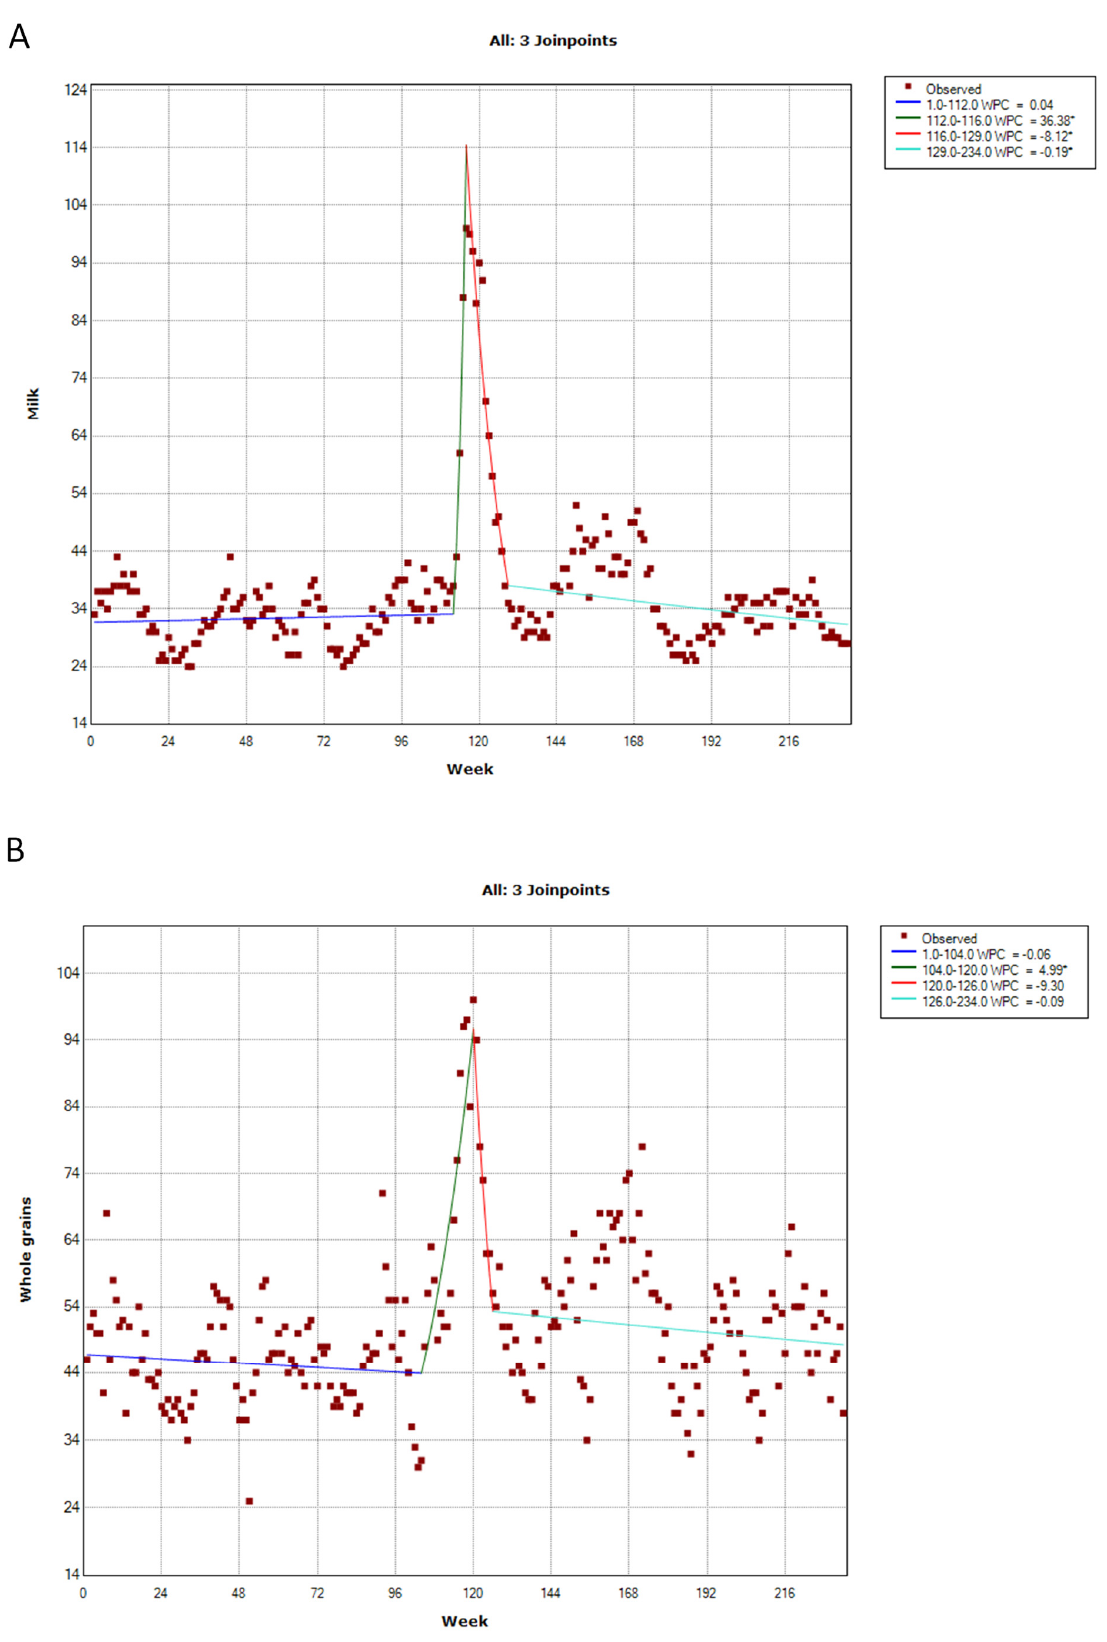
Figure 3. Joinpoint analysis of public interest in milk ( A ) and whole grains ( B ). * p -value < 0.05.